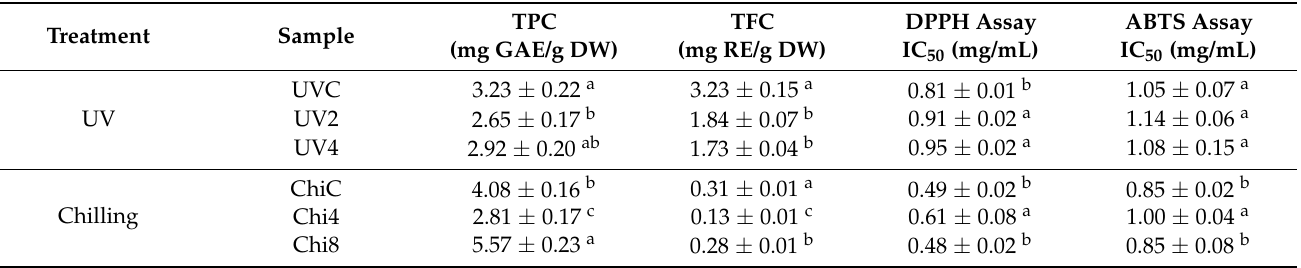
Table 1. Total phenolic (TPC) and flavonoid (TFC) contents and antioxidant response of rice seedlings against UV and chilling